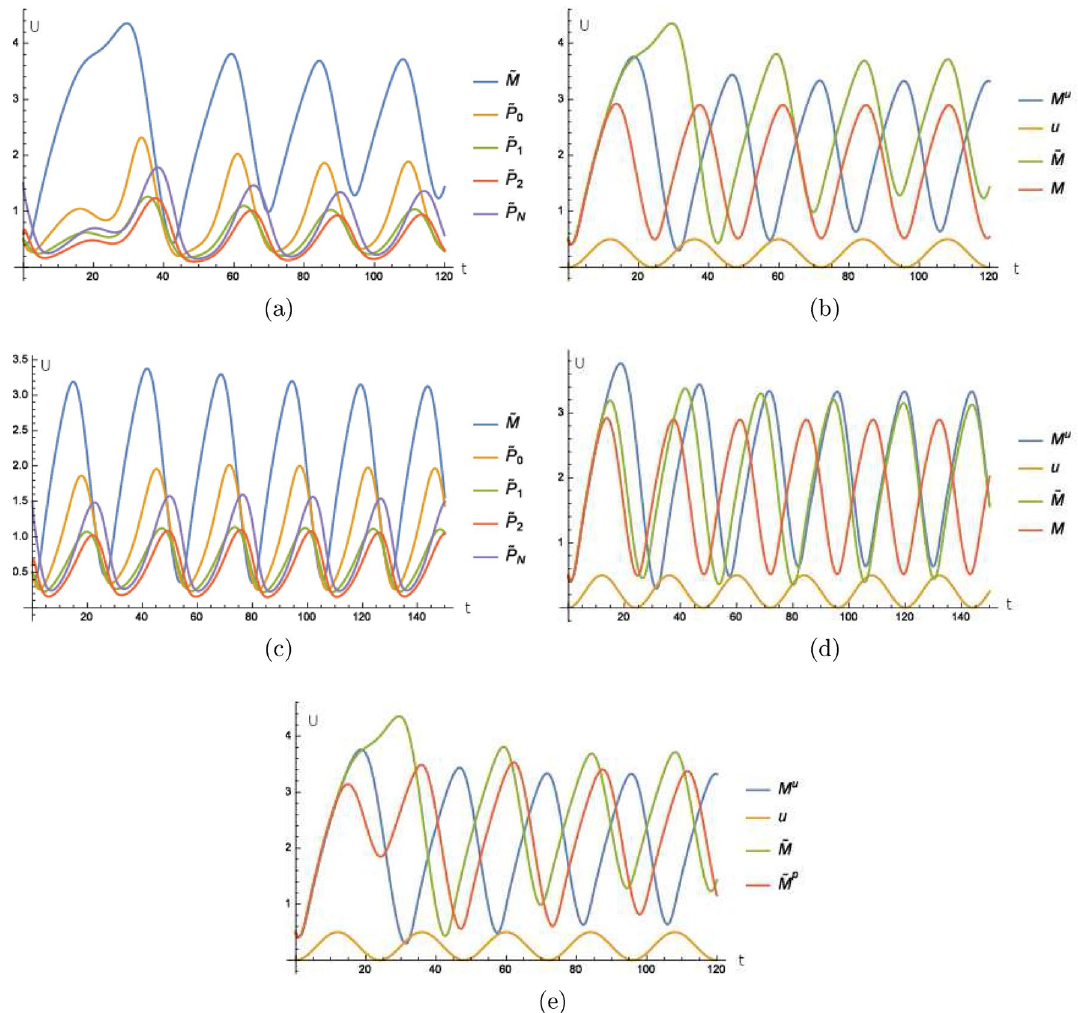
Figure 5. A peripheral oscillator coupled in antiphase to the molecular clock. ( a ) Time curves of the second oscillator where the agents ˜ M , ˜ P 0 , ˜ P 1 , ˜ P 2 and ˜ P N fulfill analog equations corresponding to (1) to (5) where (2) is replaced by (11) and ˜ α = 0.5 . ( b ) Time curve of the external stimulus u defined in (16), of M calculated from the model (1) to (5), of ˜ M calculated by an analogous model like (1) to (5) where (2) is replaced by (11) with ˜ α = 0.5 and of M u calculated from (1) to (5) where (2) is replaced by (8) with α = 1 for (16). In ( c ) and ( d ) a peripheral oscillator coupled in phase to the molecular clock. ( c ) Time curves of the second oscillator where the agents ˜ M , ˜ P 0 , ˜ P 1 , ˜ P 2 and ˜ P N fulfill analog equations corresponding to (1) to (5) where (2) is replaced by (12) with ˜ α = 0.5 , β = 2 . ( d ) Time curve of the external stimulus u defined in (16), of M calculated from the model (1) to (5), of ˜ M calculated by an analogous model like (1) to (5) where (2) is replaced by (12) with ˜ α = 0.5 , β = 2 and of M u calculated from (1) to (5) where (2) is replaced by (8) with α = 1 for (16). In ( e ) the time curve of the external stimulus u defined in (16) where M u and ˜ M are calculated as in ( a ) and ( b ). The quantity ˜ M p is calculated by an analogous model as ˜ M where (11) is replaced by (13) with α P = 0.5 . After the transient, we have a shift of about 12.7 h between M u and ˜ M and of about 15.8 h between M u and ˜ M p . Units and dimensions: abscissa t : time in hours, ordinate U : amount of substance ( M , M u , ˜ M , ˜ M P mRNA, ˜ P i , { 0, 1, 2, N } , protein, u intensity of